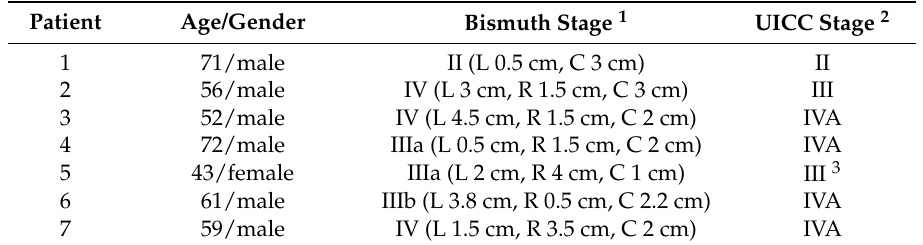
Table 1. Clinical data for the seven consecutive patients undergoing neoadjuvant photodynamic therapy